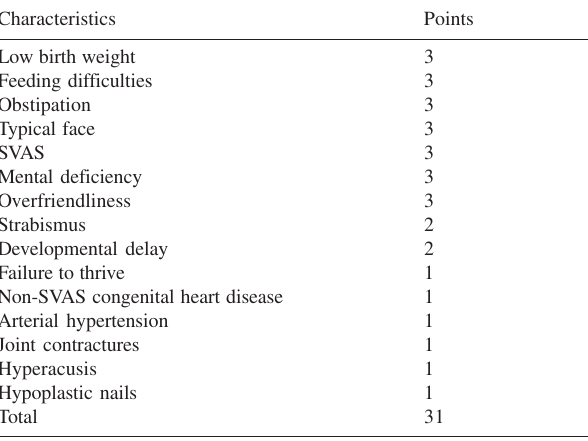
Table 1 - Phenotype scoring system of the present work Characteristics